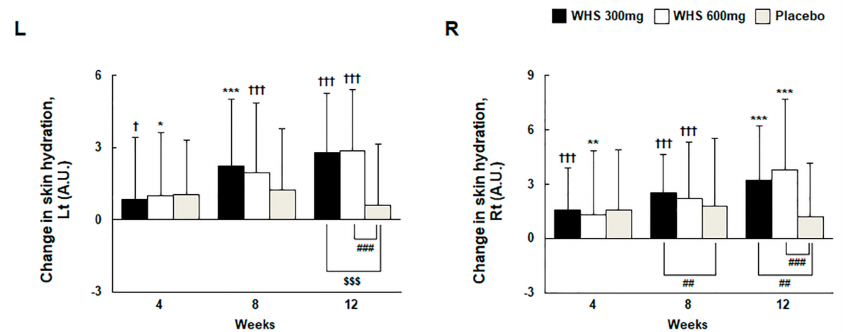
Figure 4. Changes in skin hydration with WHS or placebo administration for 12 consecutive